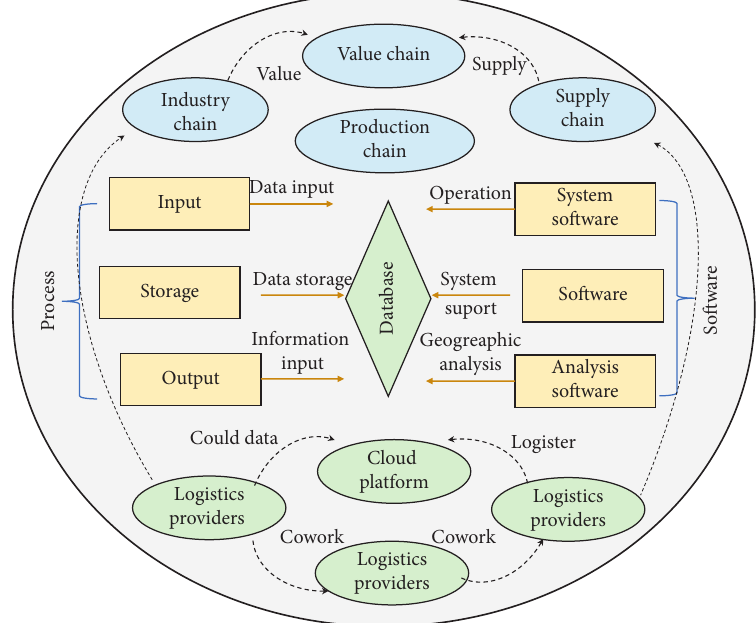
Figure 5: Value chain collaboration based on cloud platform.